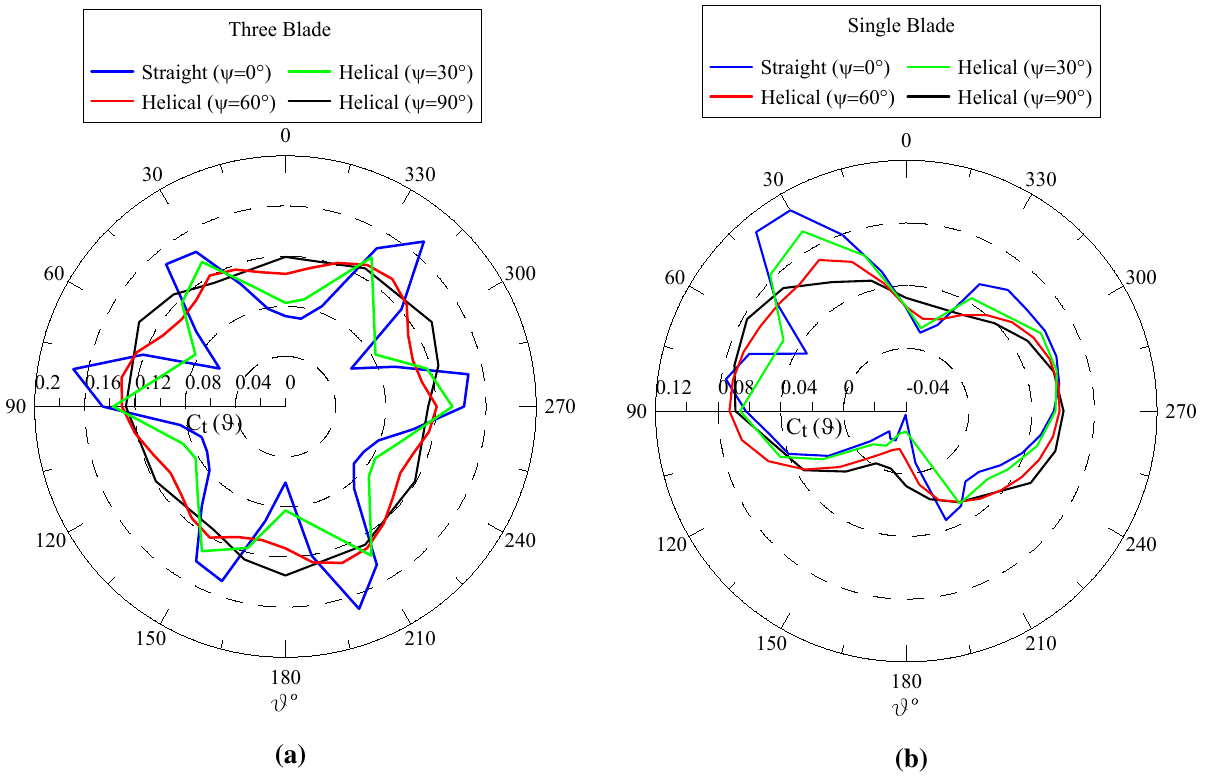
Figure 10. Static performance behavior for different azimuthal position θ values. ( a ) Turbine static three-dimensional comparison; ( b ) single-blade static three-dimensional